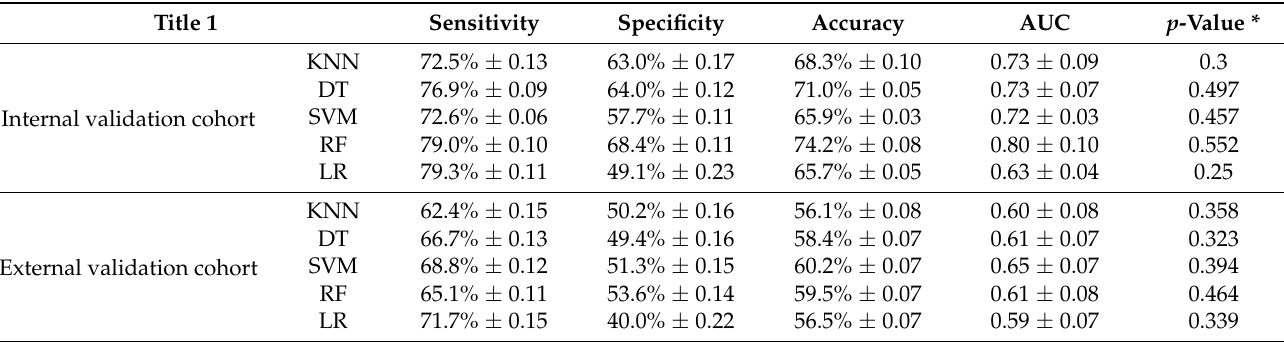
Table 5. Diagnostic performance of each